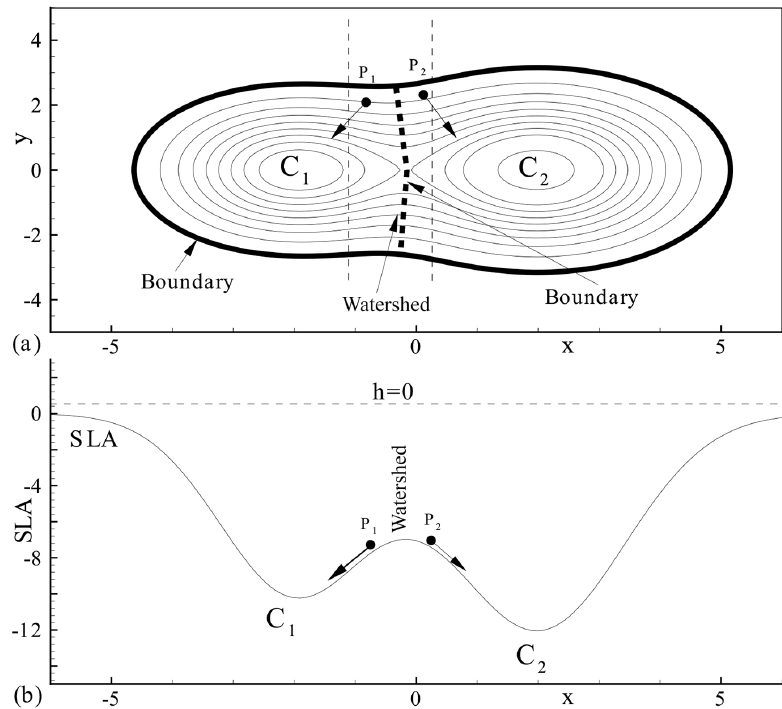
Figure 3. (a) Watershed as the natural division of eddies C1 and C2 from the top view, where contours represent SLA. (b) The particles P1 and P2 on the watershed flow downward to the eddy centers C1 and C2 from the cross-section view. After Li and Sun (2015).